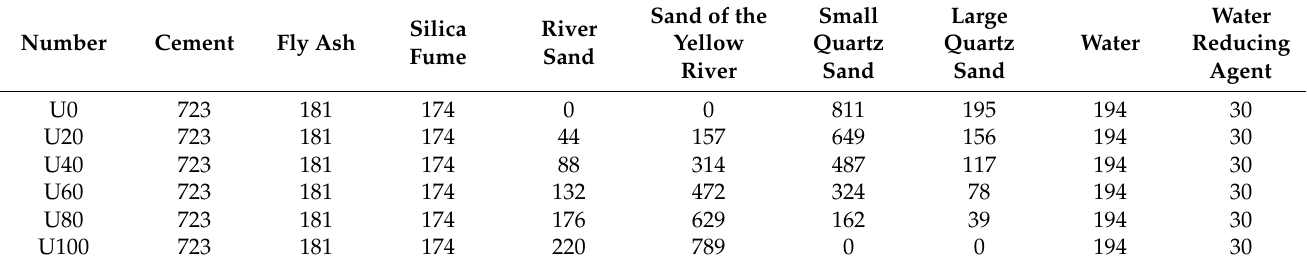
Table 2. Mix proportions of ultra-fine Yellow River sand for ultra-high-performance concrete (kg/m 3 ).